Question: What style of plot is this figure drawn as?
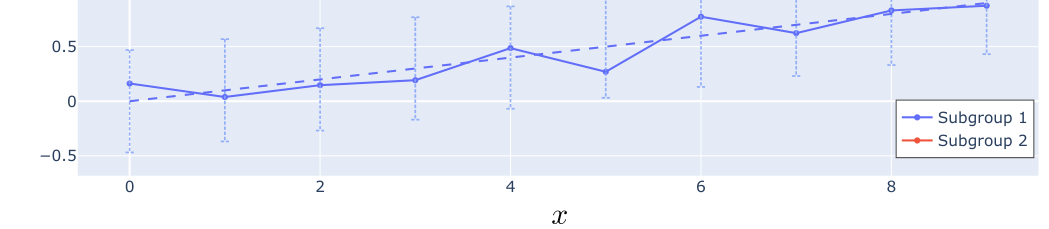
Answer: line